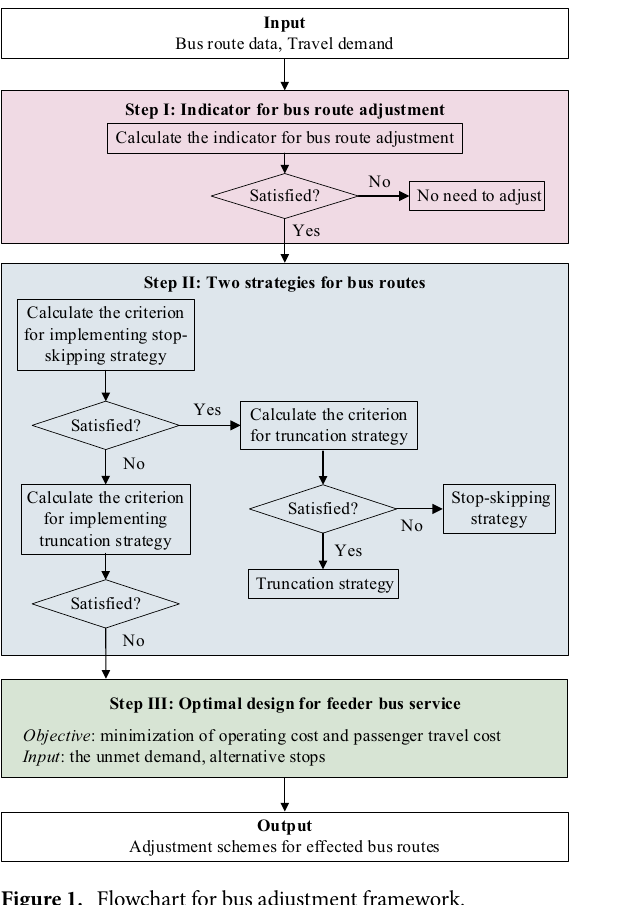
Figure 1. Flowchart for bus adjustment framework.